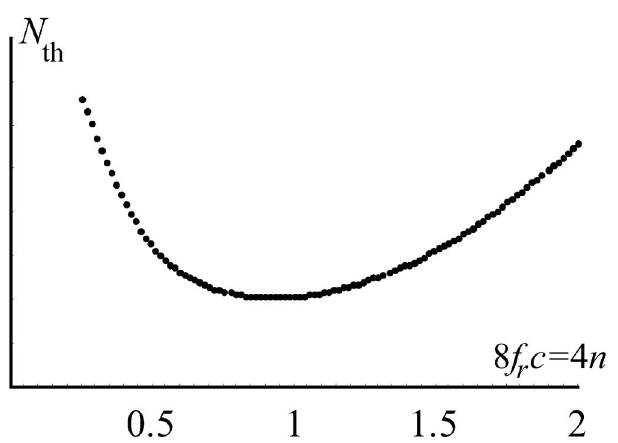
FIG. 58. (Color) Power spectra for the most unstable bunch length with n (cid:8) 1 = 2 , as well as the real and imaginary parts of the driving broadband impedance [84].